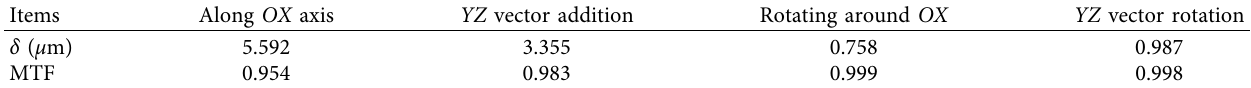
Table 3: The motion characteristics when the UAV approaches the side of beam bridge at 3m under level 2 wind. Items